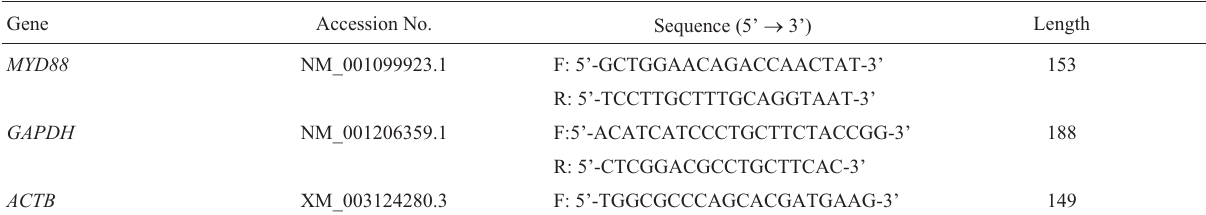
Table 1 - Real-time PCR primer